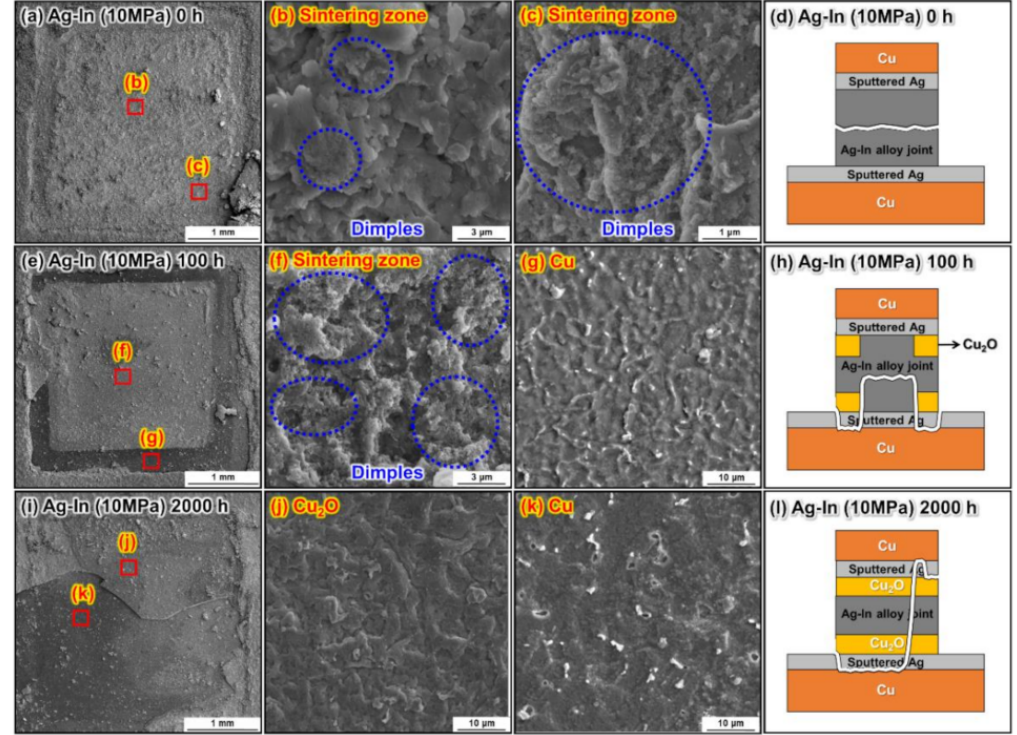
Figure 14. Surface fracture analysis of the sintered Ag–In alloy joints bonded at 10 MPa. Fracture planes of the Ag–In alloy joints ( a ) as-bonded and after ( e ) 100 h and ( i ) 2000 h of HTS at 300 ◦ C. ( b , c ), ( f , g ), and ( j , k ) are magnified images of the fracture plane areas marked in ( a , e ), and ( i ), respectively. Schematic of the crack propagation in the sintered Ag–In alloy joints bonded at 10 MPa ( d ) as-bonded and after ( h ) 100 h and ( l ) 2000 h of HTS at 300 ◦